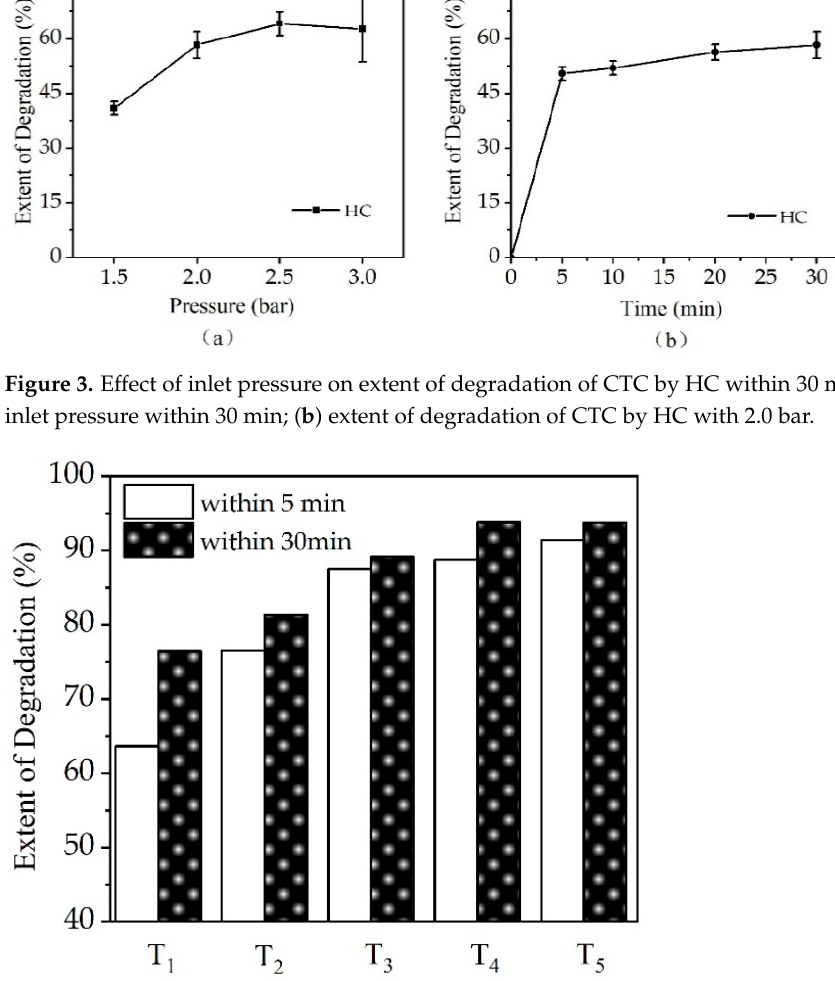
Figure 3. Effect of inlet pressure on extent of degradation of CTC by HC within 30 min: ( a ) effect of inlet pressure within 30 min; ( b ) extent of degradation of CTC by HC with 2.0 bar.